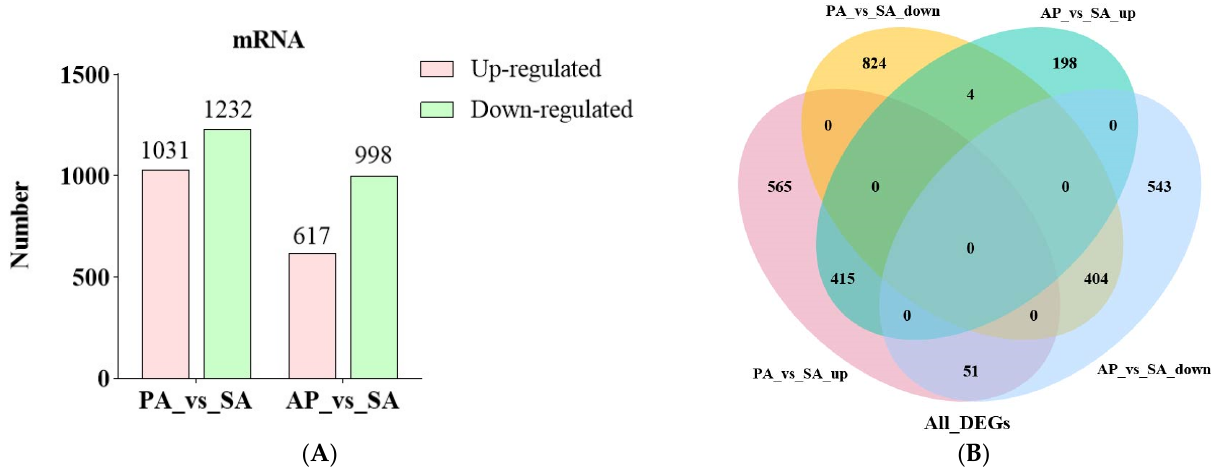
Figure 1. Statistics and Venn diagrams of differentially expressed genes (DEGs) in all samples. ( A ) Statistic diagrams of DEGs; ( B ) Venn diagrams of DEGs.